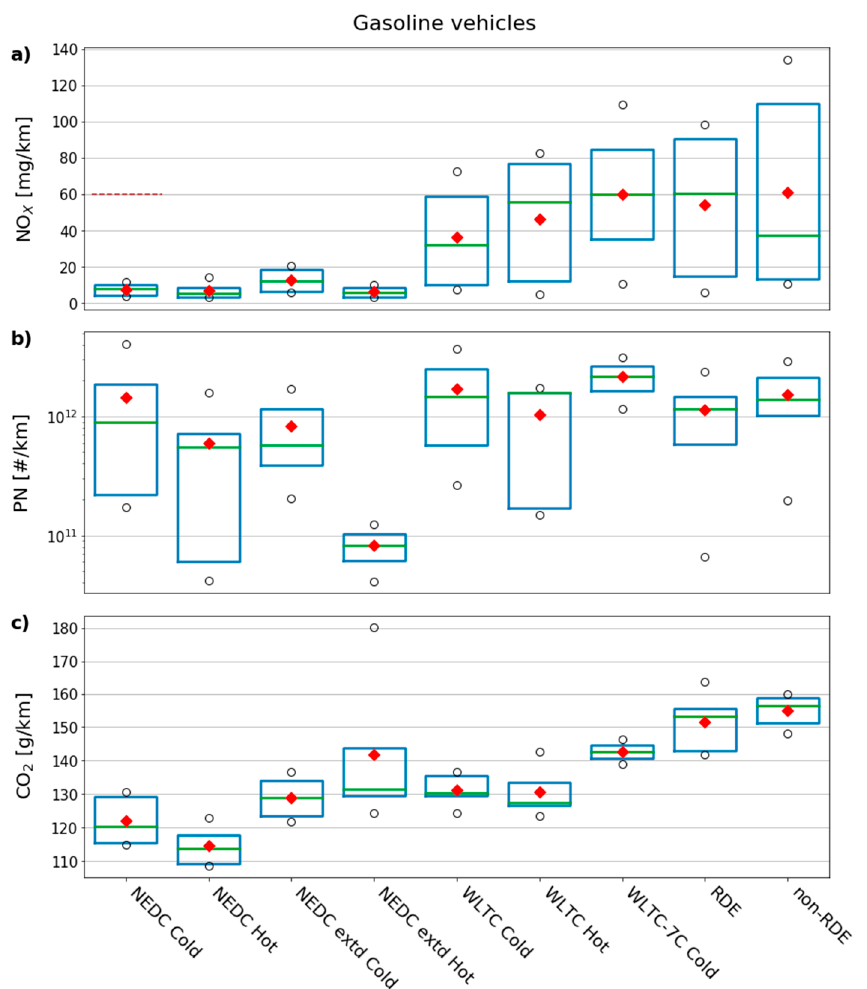
Figure 2. Boxplot of emission factors of the gasoline sample for complete tests ( a ) NO X [mg / km], ( b ) PN [# / km], and ( c ) CO 2 [g / km]. The box represents the 1st and 3rd quartile, the green line is the median, the red diamond is the mean, and the black circles are data points beyond the interquartile range. In the ( a ), the brown dashed line represents the Euro 6 emission limit at type approval for gasoline vehicles over the NEDC cold test [60 mg / km] (PN provisional limit of 6 × 10 12 # / km applicable for GDIs of this study not displayed for readability). Note that in ( b ) y -axis is logarithmic. The mean and median NO X EF over WLTC Cold were 36.2 ± 25.9 mg / km and 32.3 mg /